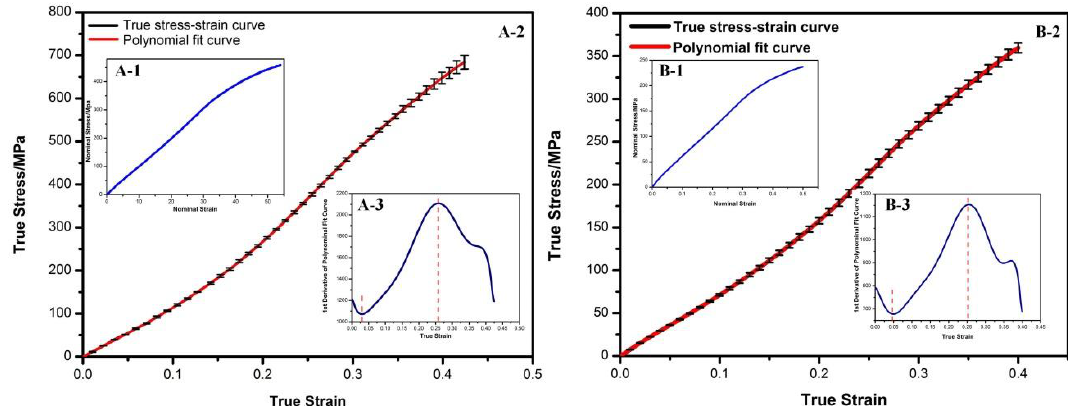
( A-1 ) Measured stress-strain curves; ( A-2 ) Calculated stress-strain curves, ( A-3 ) 1st derivative of the Measured stress-strain curves; (A-2) Calculated stress-strain curves, (A-3) 1 st derivative of the polynomial fit curve. ( B ) cMYs: ( B-1 ) Measured stress-strain curves; ( B-2 ) Calculated stress-strain polynomial fit curve. ( B ) cMYs: (B-1) Measured stress-strain curves; (B-2) Calculated stress-strain curves, ( B-3 ) 1st derivative of the polynomial fit curves, (B-3) 1 st derivative of the polynomial fit curve.